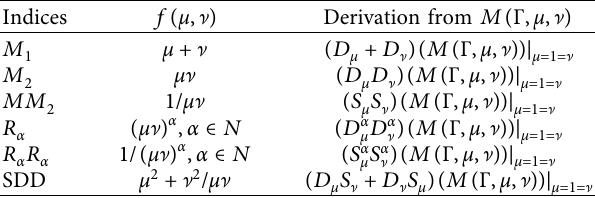
Table 1: Derivation of TIs from M-polynomial.